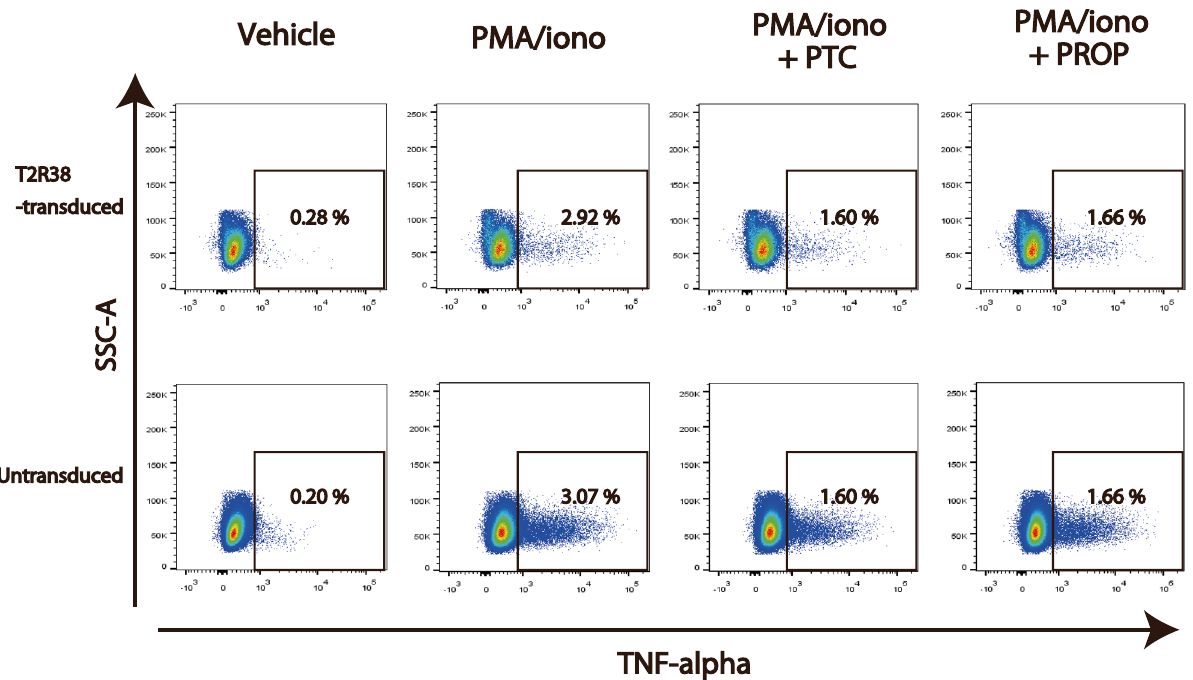
Figure 5. Comparable tumor necrosis factor (TNF)-alpha production of T2R38-transduced and T2R38- untransduced Jurkat cells to phenylthiocarbamide (PTC) and 6-n-propylthiouracil (RPOP). Jurkat cells were activated with ionomycin (1 μg/ml) and PMA (25 ng/ml) for 4 h w/wo the addition of PTC or PROP. Cells were fixed and permeabilized for flow cytometry. One representative of three independent experiments is